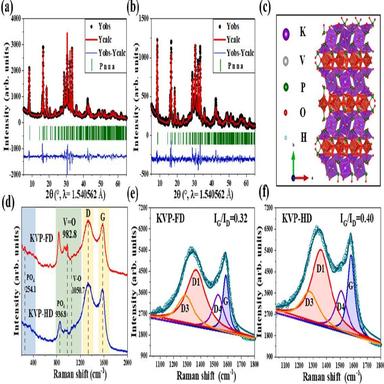
Rietveld refined structure models of the XRD patterns at 800 ◦C of (a) KVP-FD, (b) KVP-HD, (c) crystal structures of KVP (Pnnn space group), (d) Raman spectroscopy and (e-f) IG/ID ratios of KVP-FD and KVP-HD material.